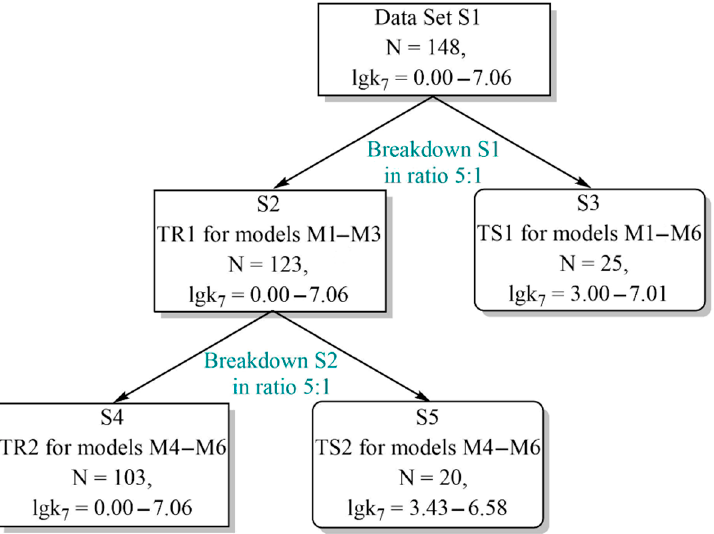
Figure 9. Construction of the training and test sets for the M1–M6 models in the design of the QSPR consensus models (S is set, TR and TS are training and test sets, M is the model, N is the number of compounds included in the corresponding sets and arrays). Designations: (1) S1 is the overall